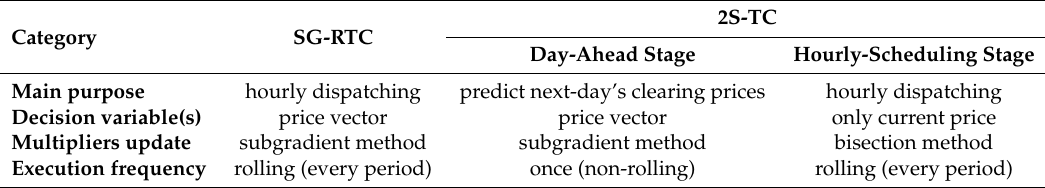
Table 1. Comparisons between subgradient-based rolling TC (SG-RTC) and